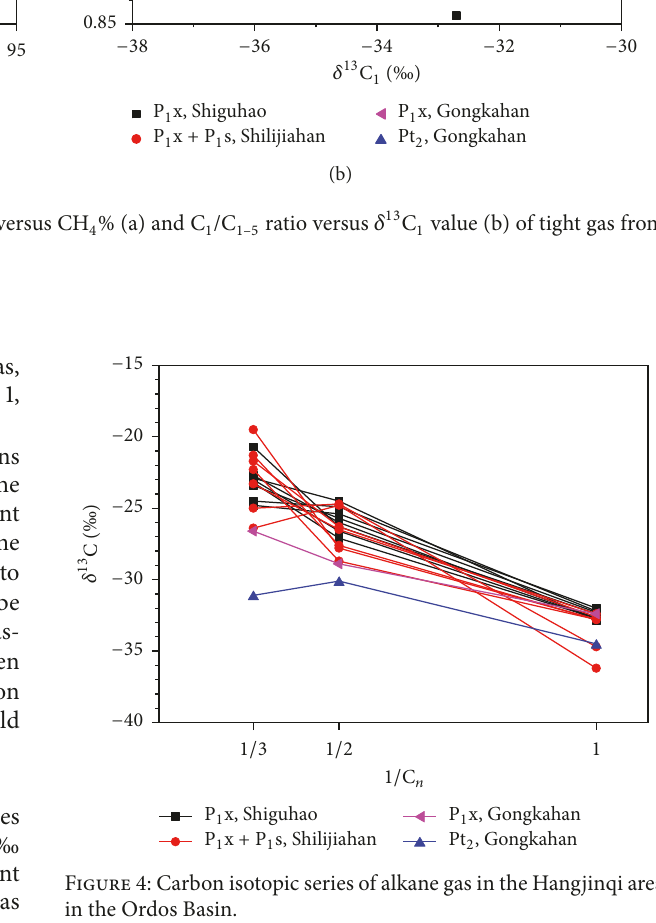
Figure 4: Carbon isotopic series of alkane gas in the Hangjinqi area in the Ordos